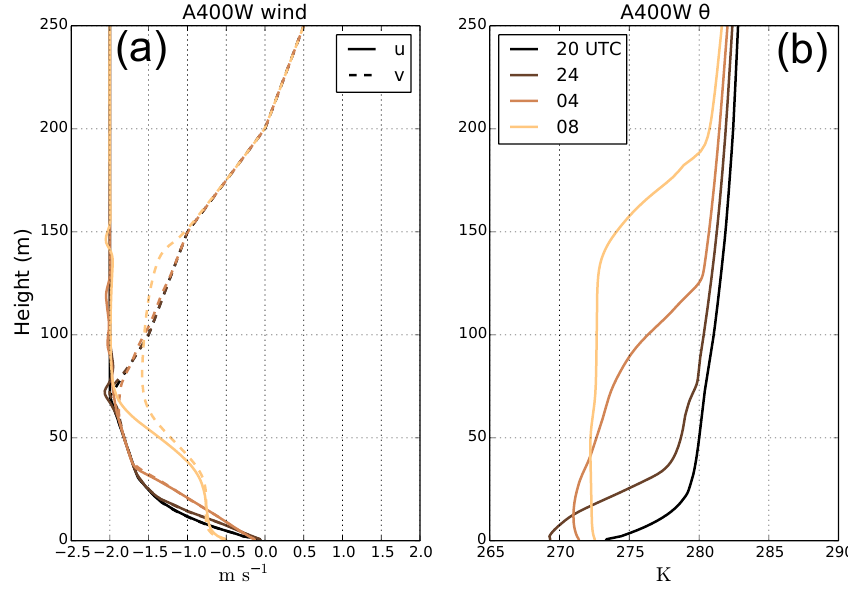
Figure 13. (a) Domain mean profiles of u and v wind components and (b) the potential temperature for the experiment A400W in 4h intervals from the formation of the fog layer (from black to